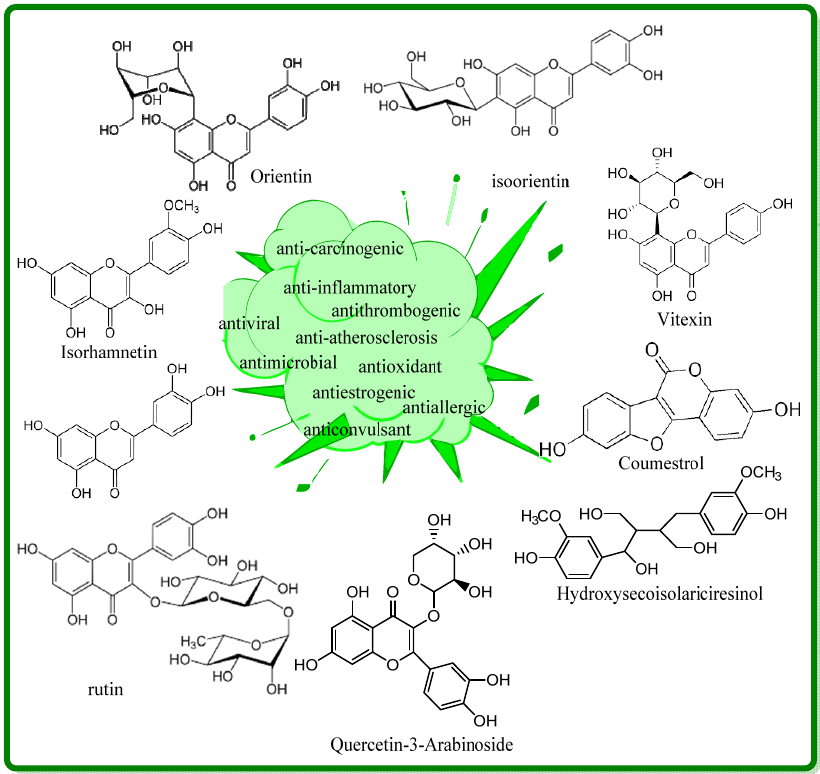
Figure 5. Main compounds of analyzed buckwheat extracts and their biologic activities.